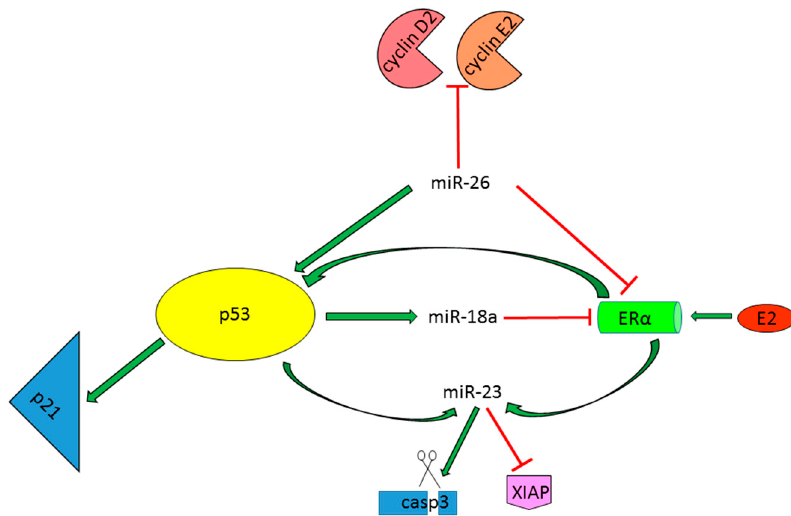
Figure 2. P53/miRNAs/ER α regulatory networks in HCC. Green arrows: Induction of gene expression or protein activation. Red lines: Inhibition of gene expression or block protein activity.